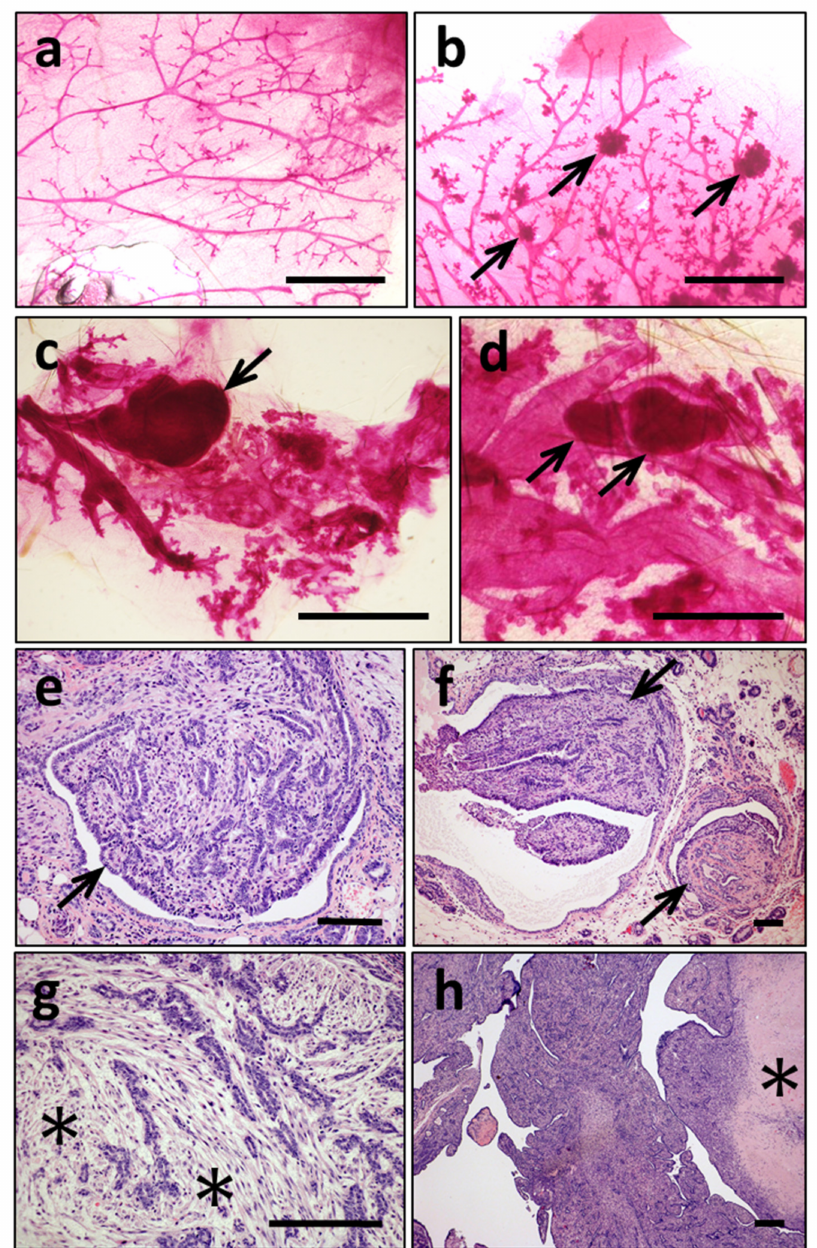
Figure 7. Gross and histological analysis of mammary gland tumors in K5-ERAS female mice. ( a – d ) Whole mount carmine alum staining of mammary glands of WT mice ( a ) and of K5-ERAS mice ( b – d ); K5-ERAS samples show multiple tumors associated to epithelial ducts and acini (ar- rows in b – d ). In ( c ) and ( d ), larger tumoral structures are seen growing inside dilated mammary ducts. ( e – h ) Representative histological features of mammary tumors in K5-ERAS female mice. ( e , f ) Intraductal carcinomas with overgrowth of myoepithelial cells (myoepitheliomas). ( g , h ) Larger my- oepitheliomas showed extensive stromal hyalinization (asterisks in ( g )) or necrotic regions (asterisk in ( h )). Bar: 2 mm in ( a – c ); 1 mm in ( d ) and 100 µ m in ( e – h